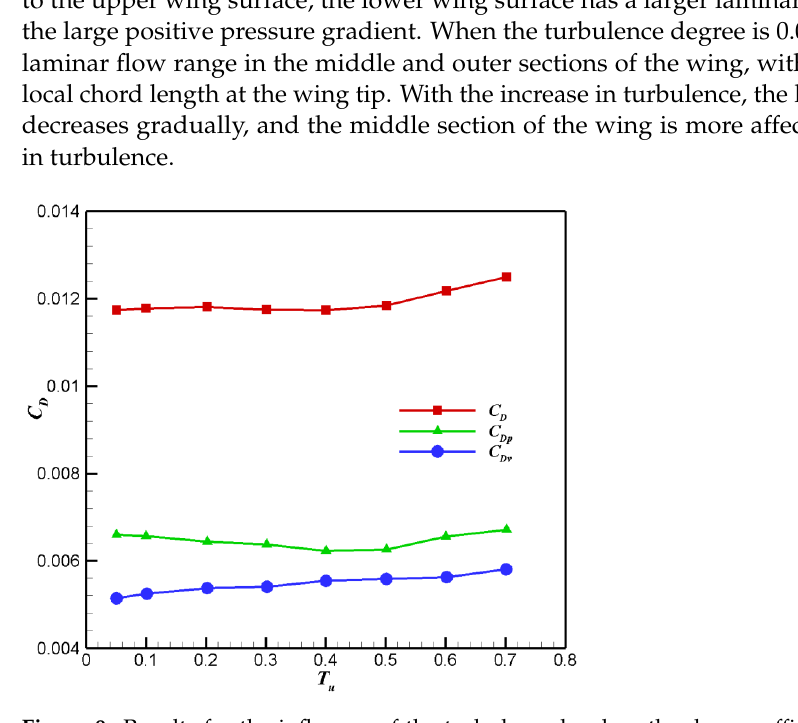
Figure 9. Results for the influence of the turbulence level on the drag coefficient (Re = 10 × 10 6 , M = 0.9, α = 2°).